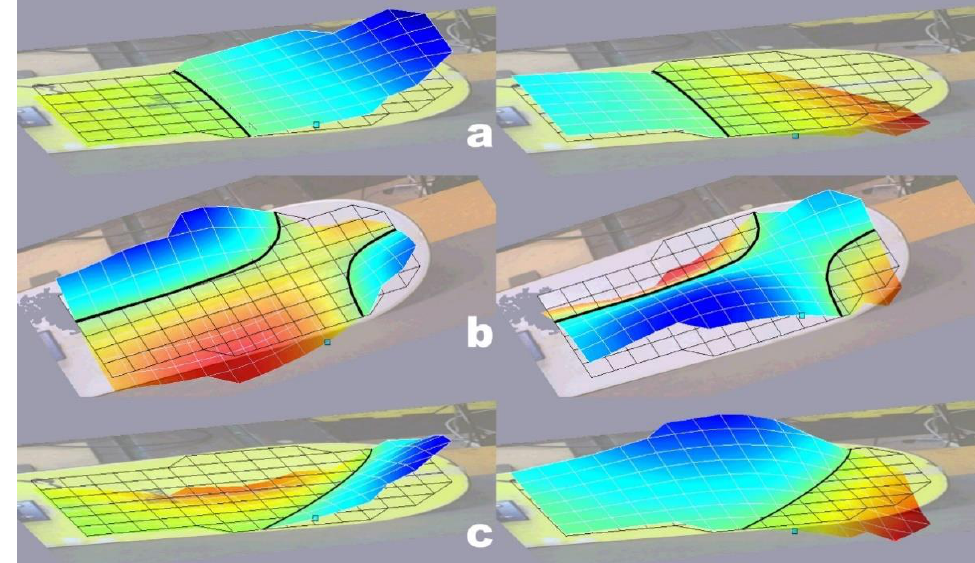
Figure 5. Vibrational modes: ( a ) bending mode; ( b ) torsional mode; ( c ) combined mode (bending + torsion); the node lines are indicated by a black curve.